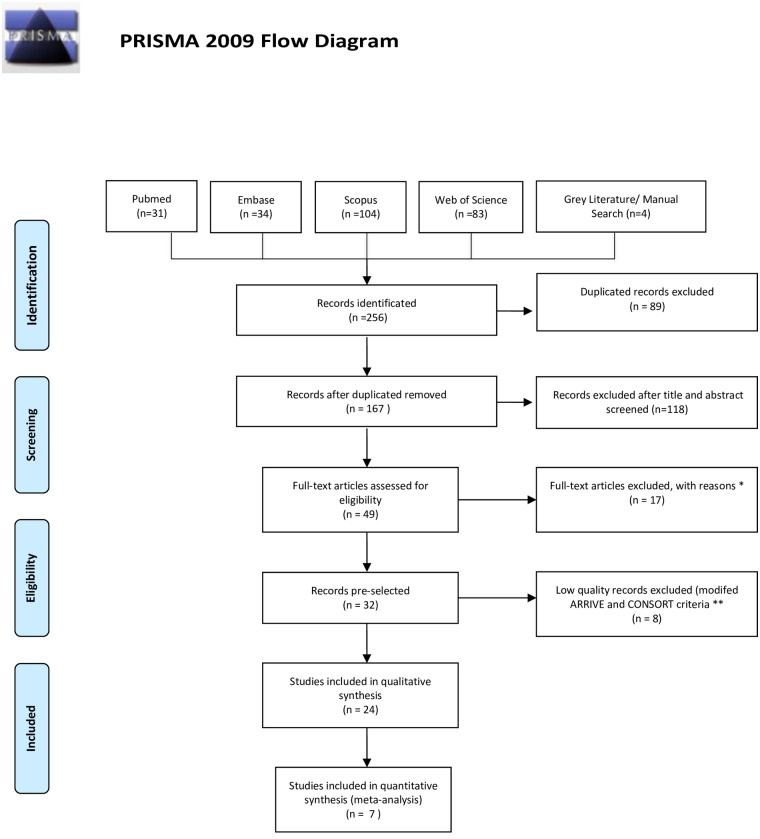
The PRISMA flow diagram.From Moher D, Liberati A, Tetzlaff J, Altman DG, The PRISMA Group (2009). Preferred Reporting Items for Systematic Reviews and Meta-Analyses: The PRISMA Statement. PLoS Med 6(7): e1000097. doi:10.1371/journal.pmed1000097.*: 5 only studied monomethacrylates, 3 only studied dimethacrylates, 3 studied provisional restoration repair, 2 used thermoplastic polyester, 1 examined provisional cement, 1 assessed reinforcing monomethacrylate materials with fiberglass, and 2 were narrative literature reviews **: Incomplete description of materials, methods or details of the experimental procedure, difficult to replicate the test, not following standardized test procedures, not describing bias reduction strategies, no calculation of sample size, incomplete statistical analysis, no conflict of interests statement, Limited interpretation and comparison of results with the available literature.For more information, visit
www.prisma-statement.org.